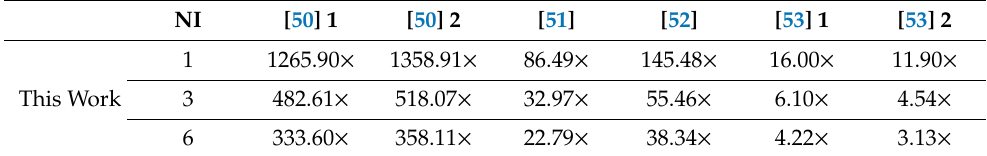
Table 19. Analysis of dynamic